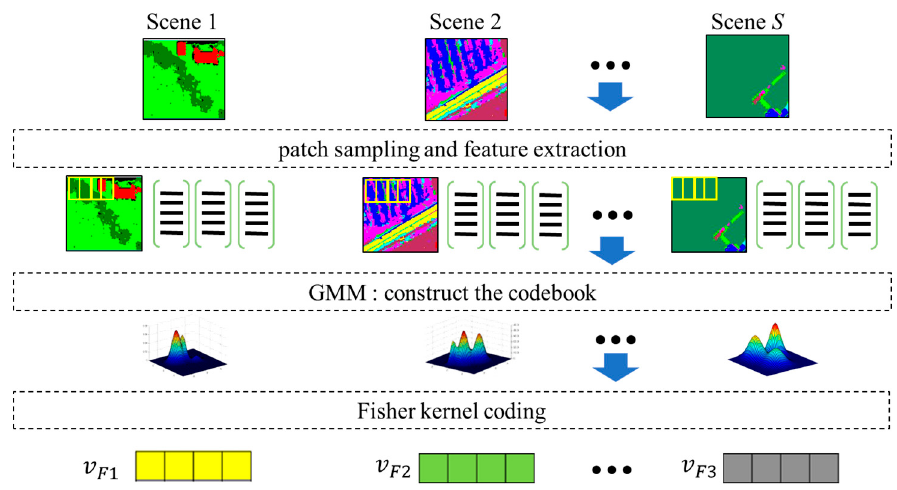
Figure 4. The construction of the co-occurrence relations.